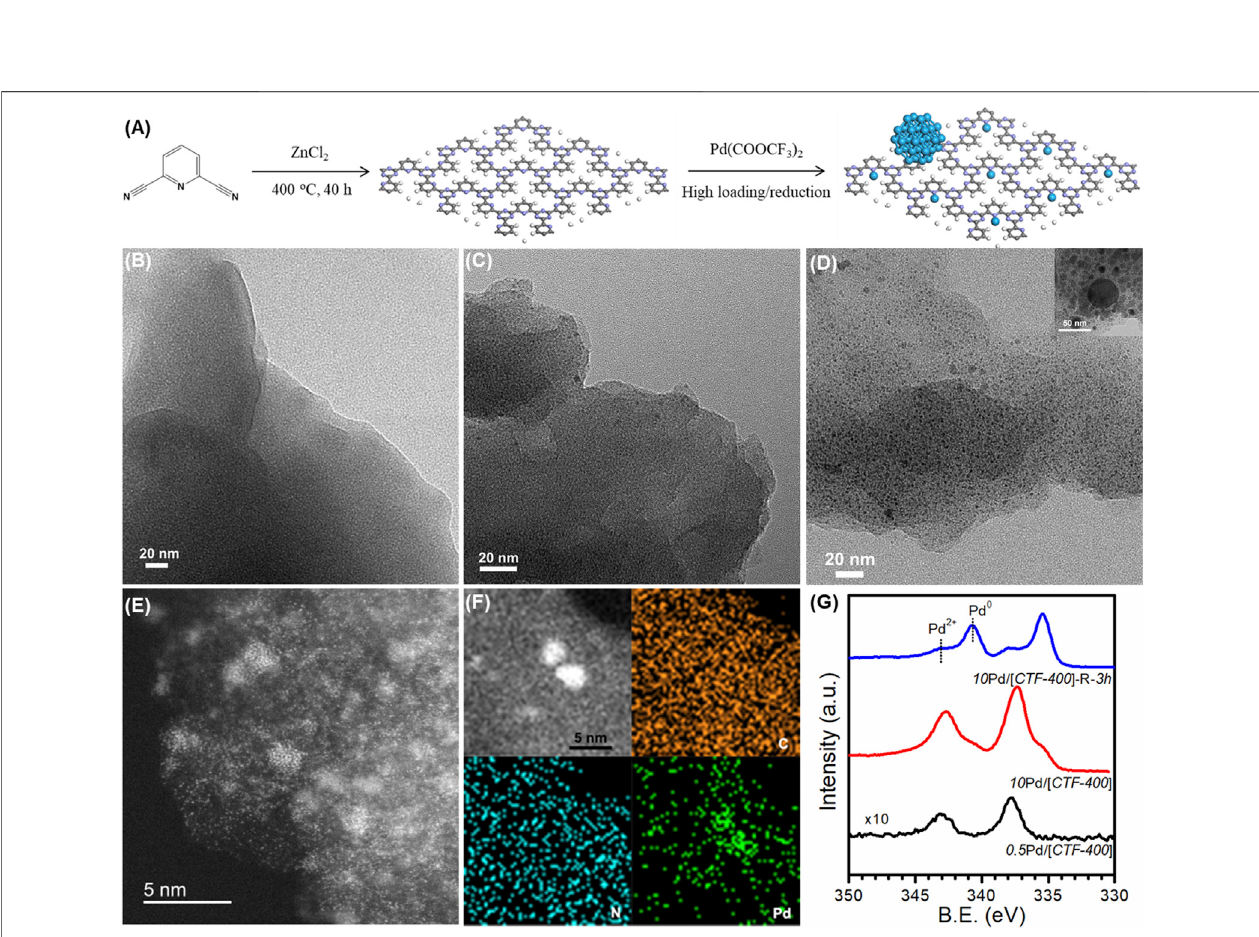
FIGURE2 | Structural characterizations of Pd/[ CTF-400 ]. (A) Schematic illustration of the fabrication procedures of Pd/[ CTF-400 ]. (B – D) HRTEM images of the characterization of 0.5 Pd/[ CTF-400 ], 10 Pd/[ CTF-400 ], and 10 Pd/[ CTF-400 ]-R- 3h . (E,F) Aberration-corrected STEM and EDS mapping of 10 Pd/[ CTF-400 ]. (G) XPS pro fi les for 0.5 Pd/[ CTF-400 ], 10 Pd/[ CTF-400 ], and 10 Pd/[ CTF-400 ]-R- 3h samples.